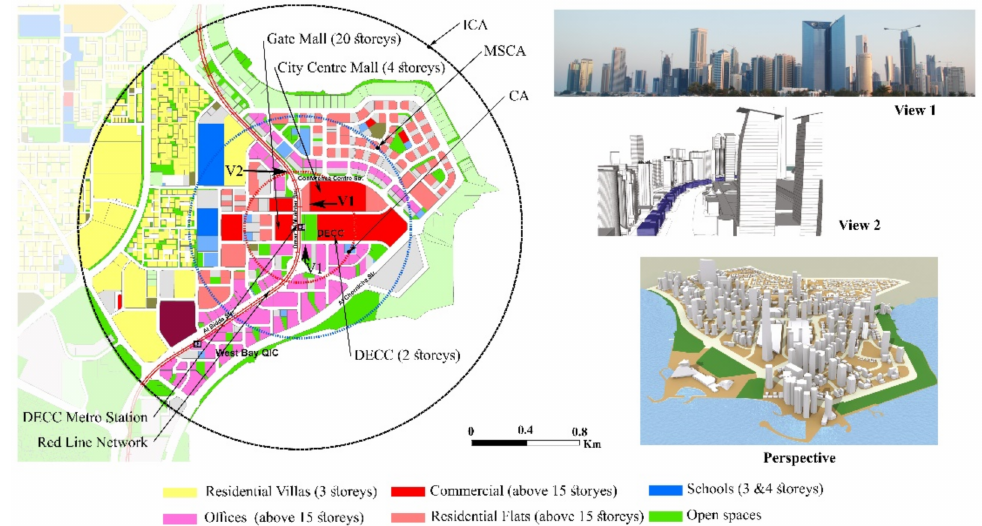
Figure 11. Existing building heights within DCA of the DECC metro